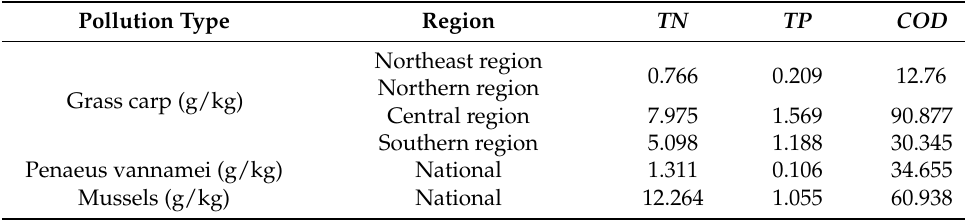
Table A3. TN, TP and COD discharge coefficients of grass carp, Penaeus vannamei and mussel in different regions of China